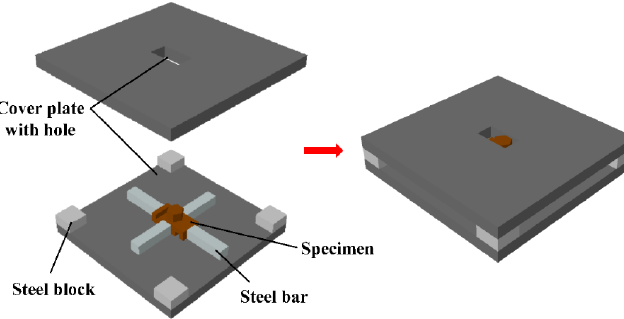
Figure 4. Adhesive thickness control method.